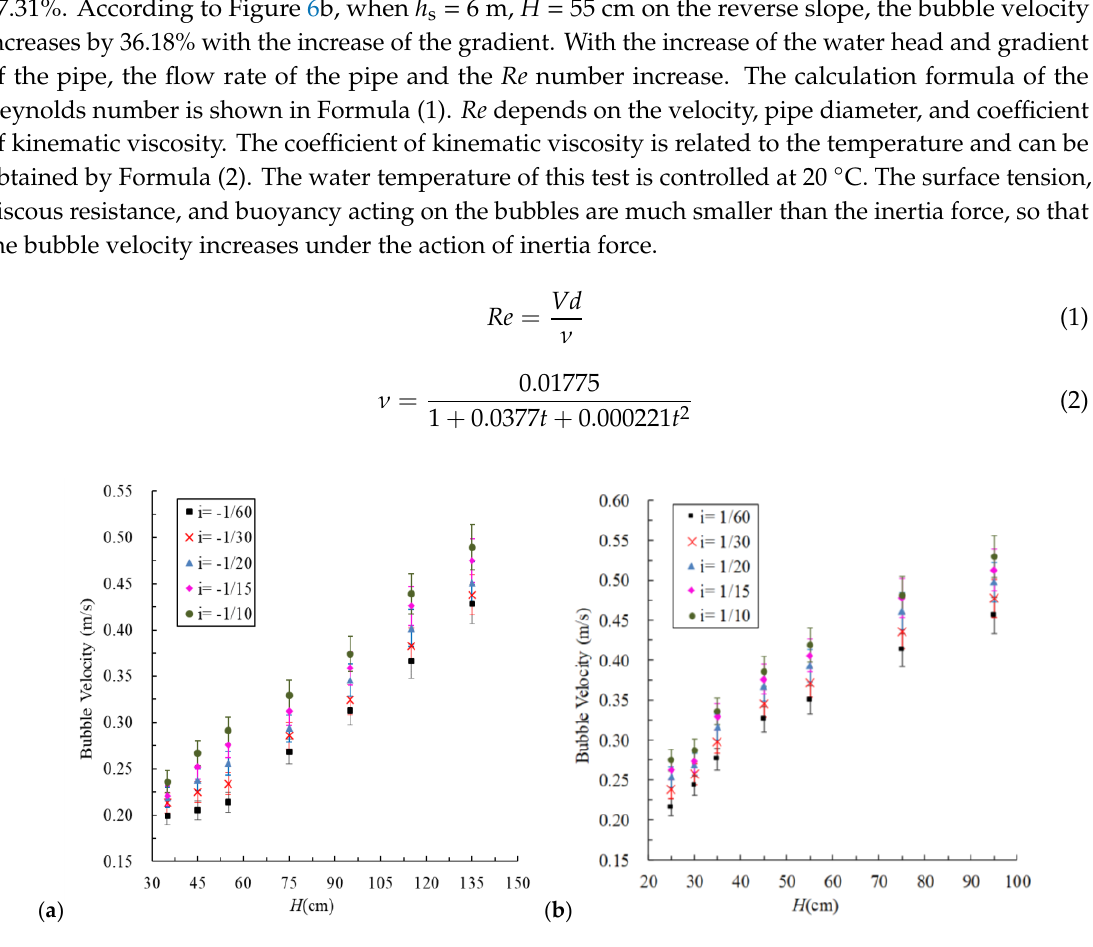
Figure 6. Relationship between the bubble velocity and water head, gradient: ( a ) h s = 4 m, ( b ) h s = 6